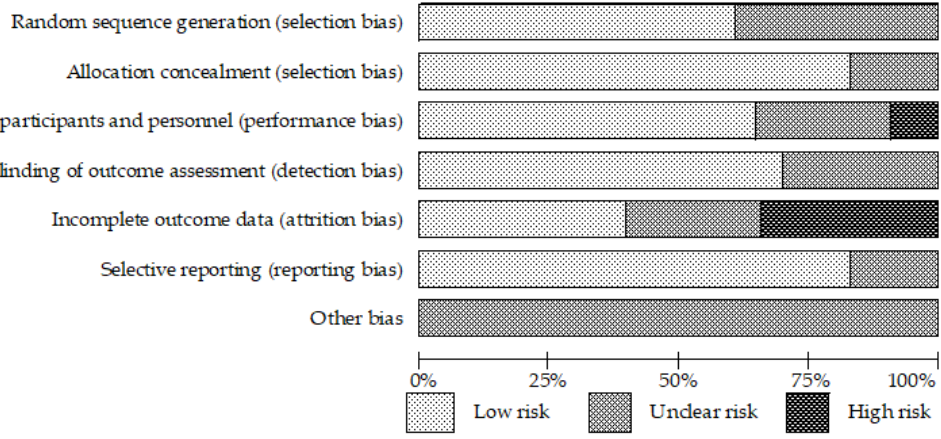
Figure 3. The summary of authors’ evaluation of each category of Cochrane risk bias for all included studies in percent.